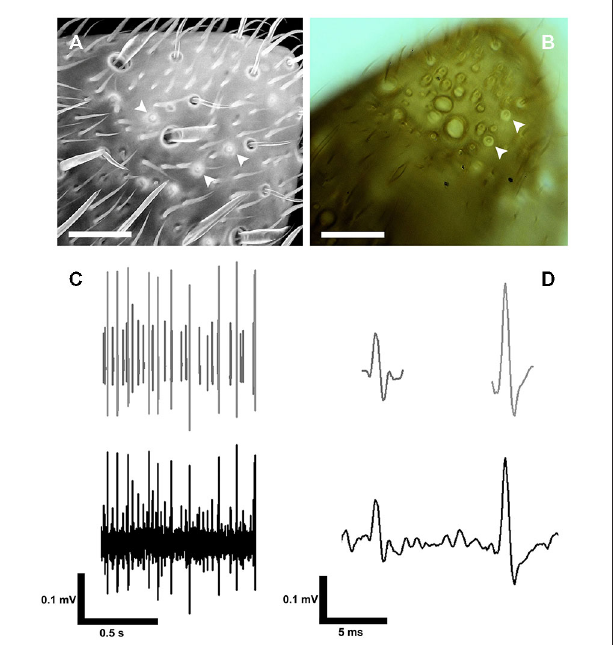
FIGURE 2 | FIB-FESEM- and TEM-images of the S. coelocapitulum. Sagittal view of the cuticular pit of one S. coelocapitulum. The distal part of the pit is enlarged compared to the proximal part. (B) The compact proximal part of the pit reaches 1 µ m and the hollow distal part reaches 2.5 µ m deep into the antennal lumen. The insertion of the dendritic outer segments of the sensory neurons into the sensory peg is tilted. (C,D) Sagittal TEM-Images of two different S. coelocapitula. (C) The cuticular pit (p), the outer dendritic segment (ods), the dendritic sheath (ds), and three supporting cells (tormogen (to), trichogen (tr), thegocen (th)) are visible. (D) The lamellation of the trichogen cell and the proximal end of the pit define the sensillum lymph cavity (slc). Scale in (A,B) : 1 µ m, scale in (C) : 0.5 µ m, scale in (D) : 0.1 µ m.